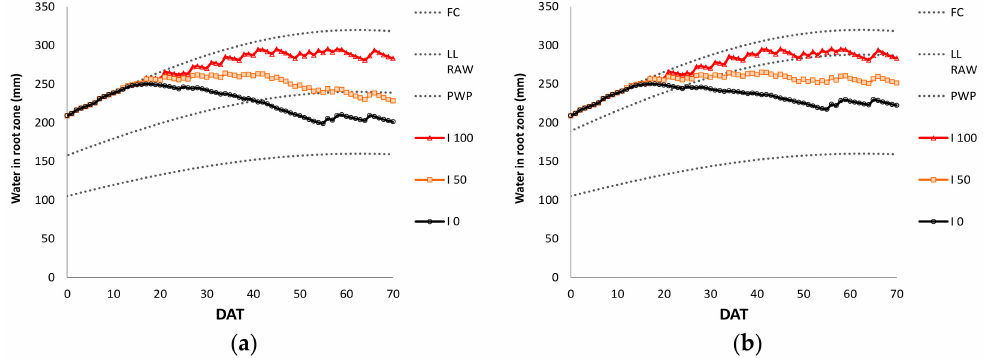
Figure 4. Total soil water in root zone during the irrigation season (0–70 DAT) for the three irrigation treatments (I 0 , I 50 and I 100 ), estimated from water balance (ex-post basis), considering di ff erent values for the depletion factor to estimate Ks: ( a ) p = 0.5, ( b ) p = 0.2, and assuming equal values for Kc in all treatments (see